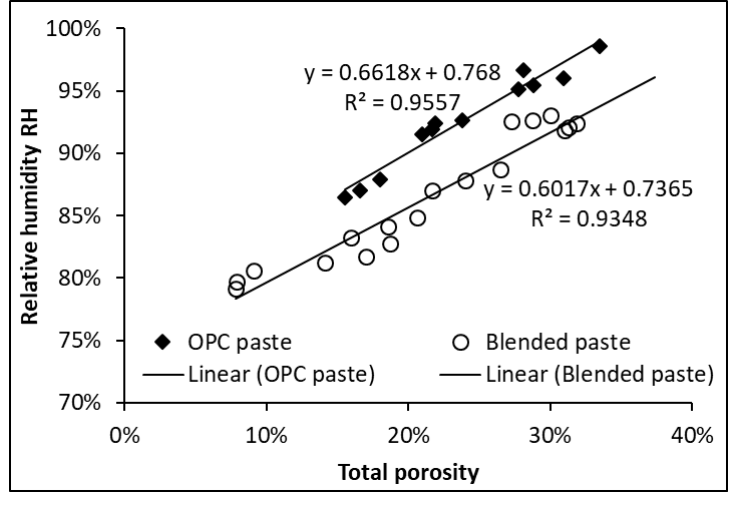
Figure 9. Relative humidity and total porosity in OPC and blended pastes.